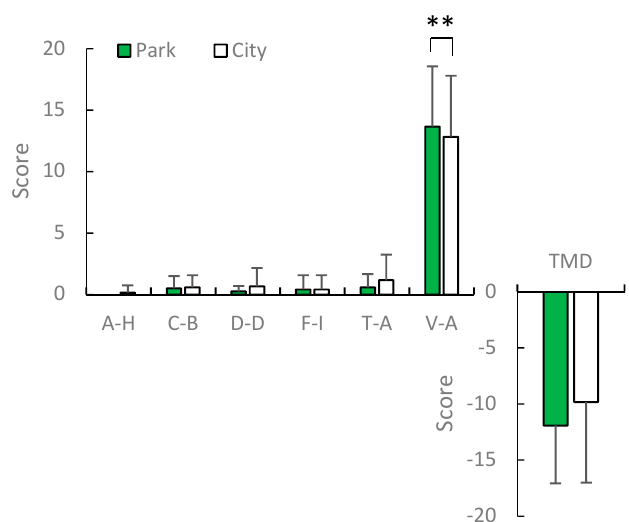
Figure 6. POMS scores after viewing in the urban park and city area in spring. A–H: anger–hostility; C–B: confusion–bewilderment; D–D: depression–dejection; F–I: fatigue–inertia; T–A: tension–anxiety; V–A: vigor–activity. N = 12, mean ± standard deviation. ** p < 0.01, determined by the Wilcoxon signed-rank test (one-sided).